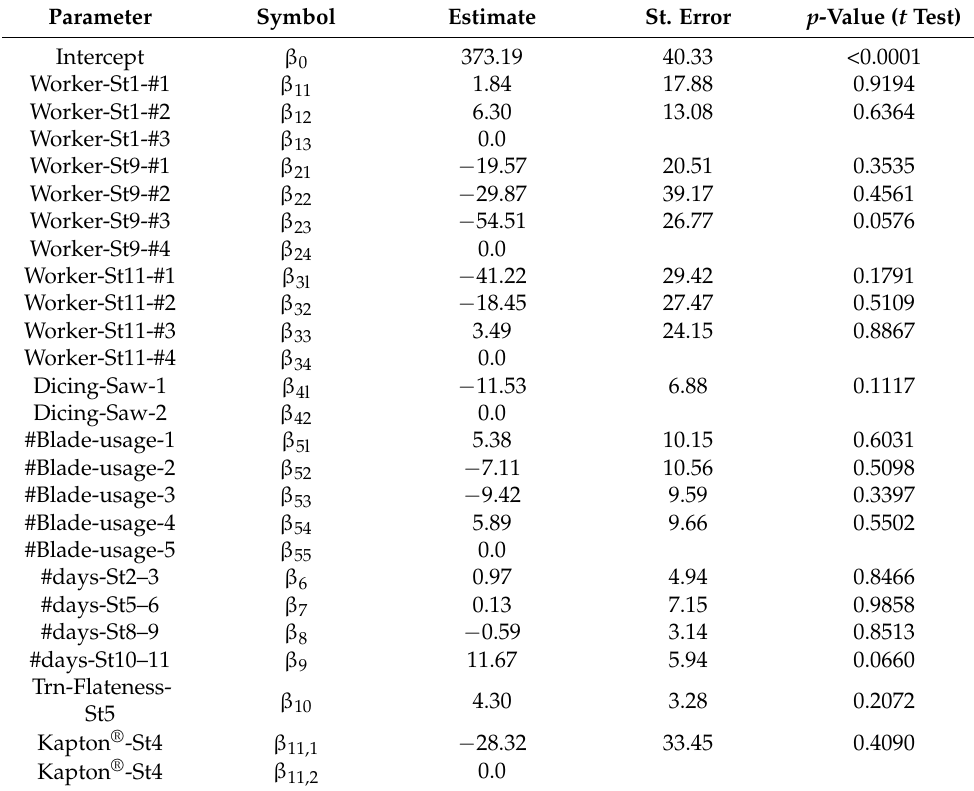
Table 1. Model results. Response Y = Sensitivity; Formula